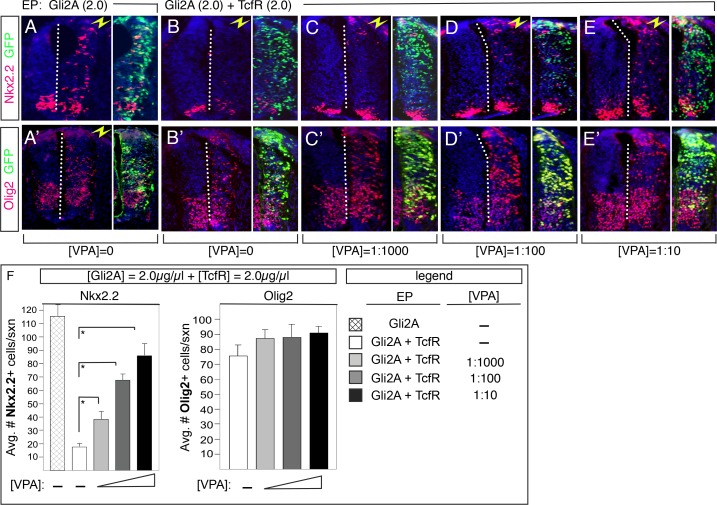
HDAC activity is required for Tcf repression of Gli2A-induced Nkx2.2 expression in vivo.(A-E) Sections through E3 chick embryos electroporated with Gli2A (at 2.0 μg/μl) and Gli2A+Tcf4R (at 2.0 μg/μl) in the presence of increasing concentrations of VPA. Right side was transfected in all cases. Note that the number of induced Nkx2.2+ cells increases with increasing VPA, indicating that Tcf4R antagonism becomes less effective at higher concentrations. (A’-E’) Olig2 expression in embryos transfected with Gli2A and Gli2A+TcfR in the presence of increasing concentrations of VPA. No effect is seen on Olig2 expression. (F) Quantification of data in A-E’. Inset at bottom right indicates corresponding bar chart shading. *p<0.001.